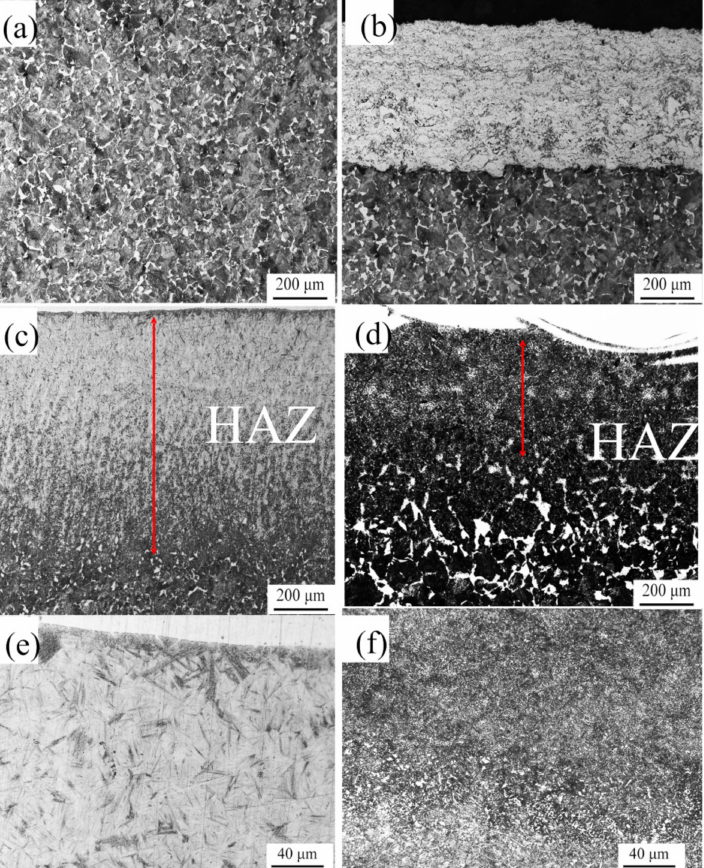
Figure 6. ( a ) the microstructure of substrate; ( b – d ) the cross section of No. 1–3; ( e ) and ( f ) present the HAZ details of the LC Ni625 and EHLA Ni625